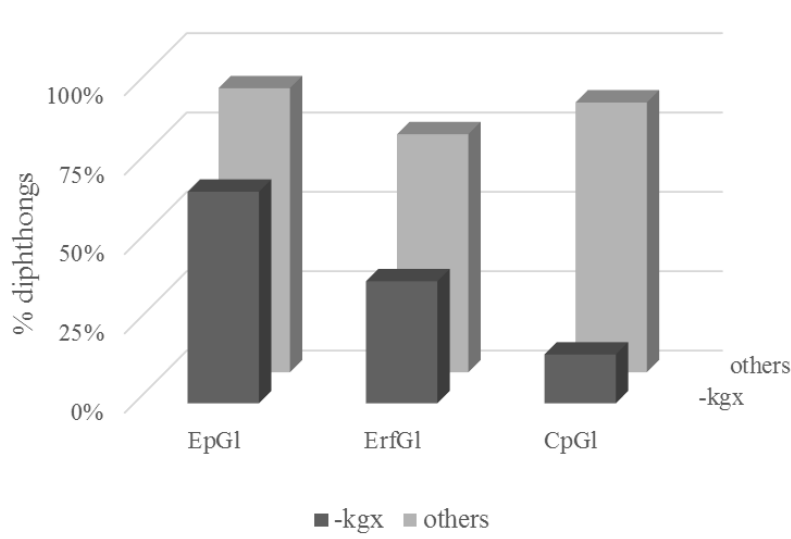
Figure 1 : The application of monophthongization of PGmc * au before velar consonants, - k /- g /- x in the three Mercian